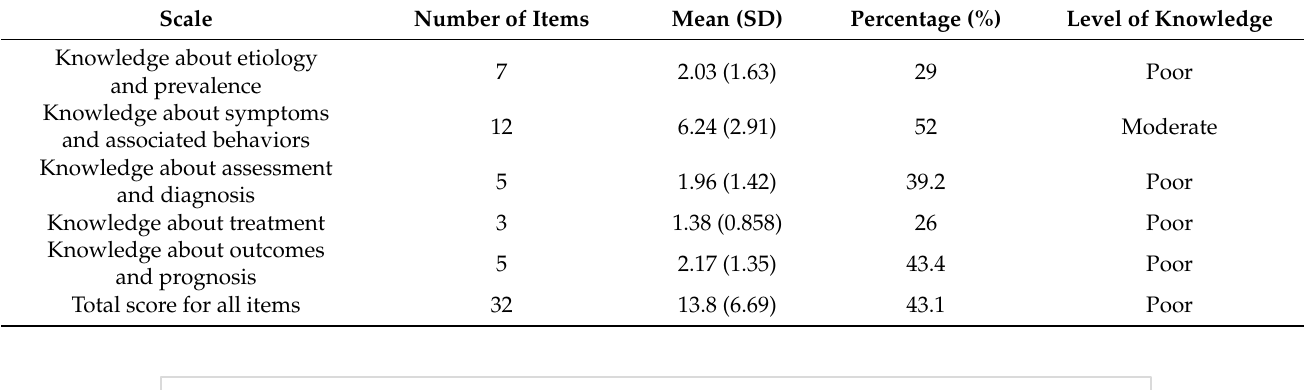
Table 5. Scores overall and subscales.